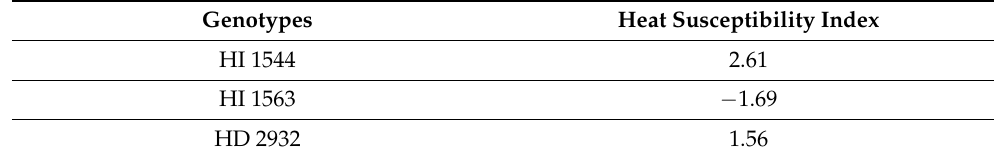
Table 3. Heat susceptibility indices of wheat genotypes grown under HNT compared to control